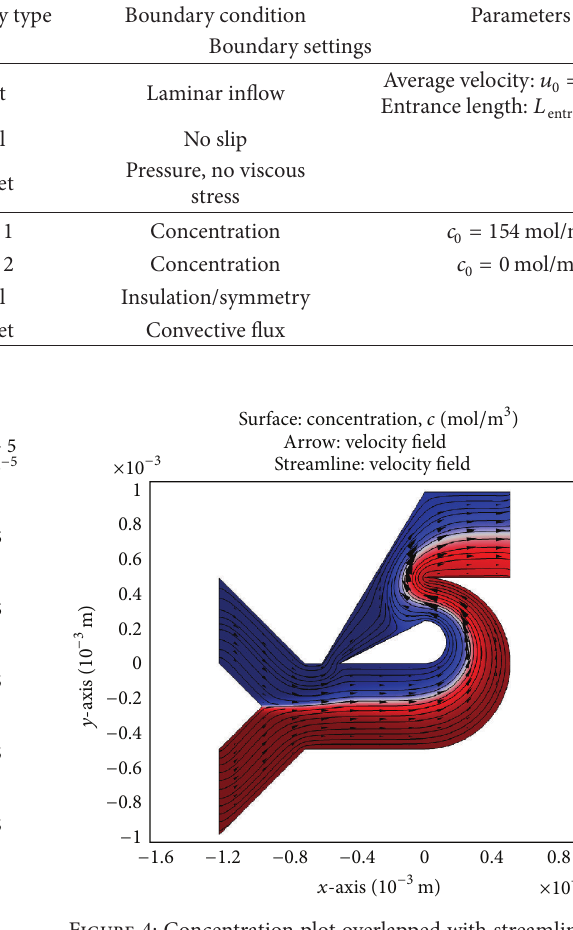
Figure 4: Concentration plot overlapped with streamline plot and arrow graph of the velocity field for the micromixer with one modified tesla element (Comsol